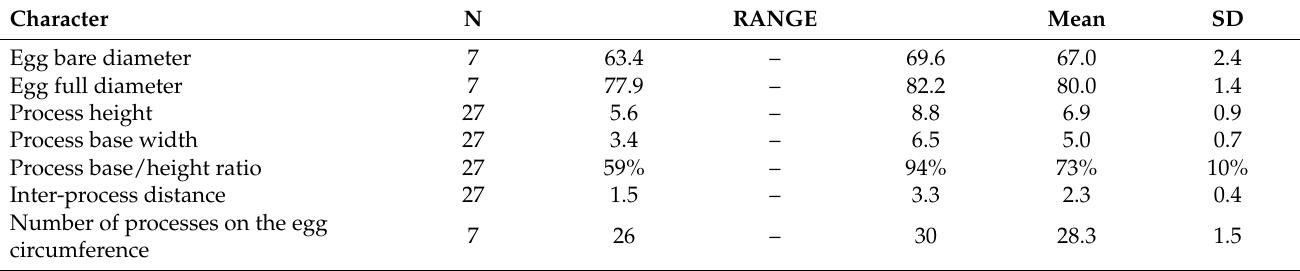
Table 6. Measurements [in µ m] of the eggs of Mesobiotus marmoreus sp. nov. ; eggs mounted in Hoyer’s medium; process base/height ratio is expressed as percentage; N—number of eggs/structures measured, RANGE refers to the smallest and the largest structure among all measured specimens; SD—standard